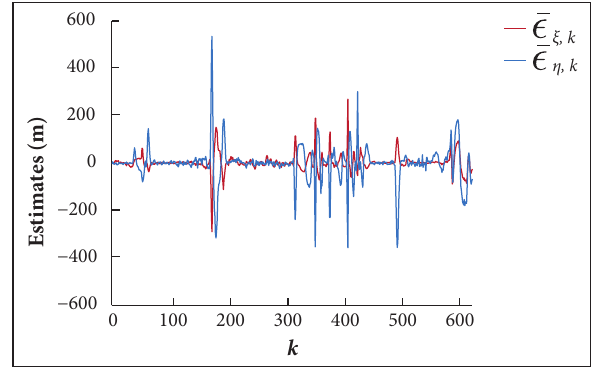
Figure 4. Estimated averages of IMMPDAF errors from simulation.